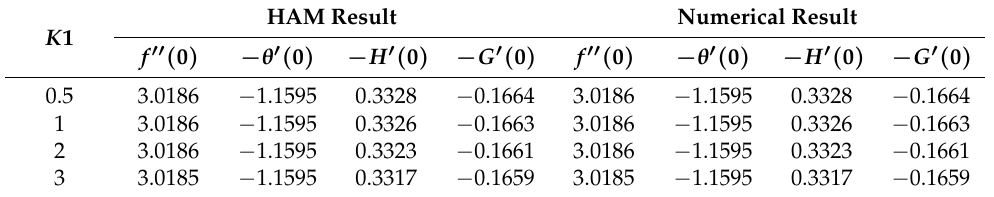
Table 11. Computational for f (cid:48)(cid:48) ( 0 ) , − θ (cid:48) ( 0 ) , − H (cid:48) ( 0 ) and − G (cid:48) ( 0 ) with S = − 0.5, P r = Ha = Sc = R = K 2 = 0.5, L = δ = 2, Q = 4 and differing values of K 1.